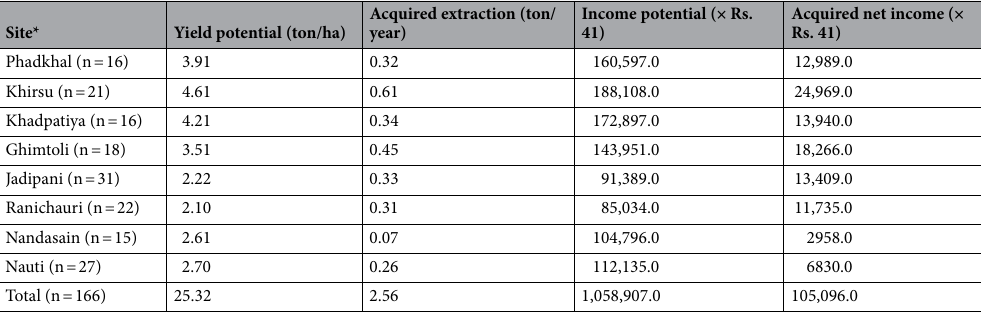
Table 5. Comparative analysis of yield potential and income acquired at different sites (yield potential refers to total flower yield in ton/ha and acquired extraction refers to total numbers of household engaged for flower extraction activities ton/year). *n = represent number of flower harvesting